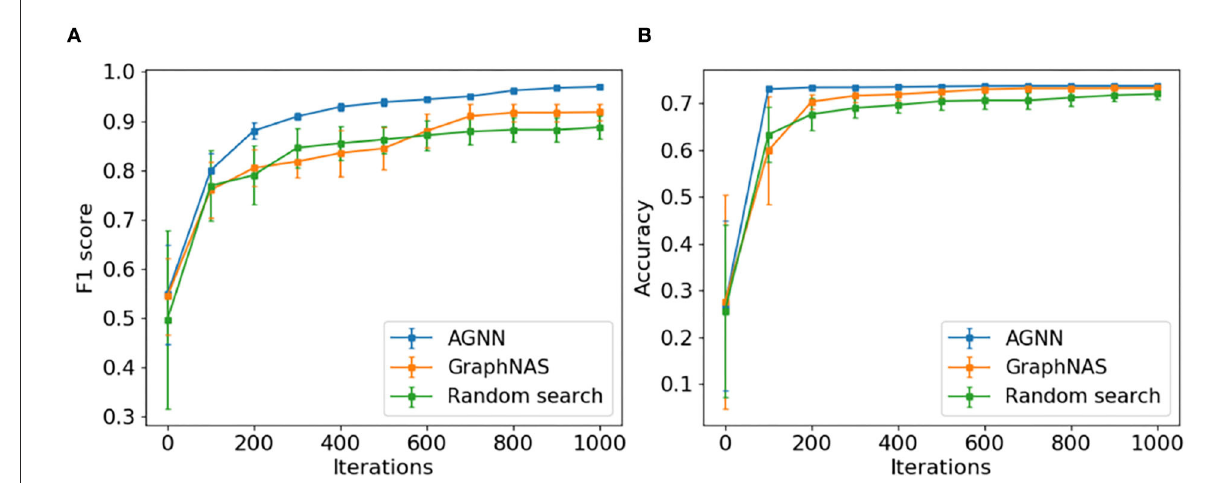
FIGURE3 The progression of top-10 averaged performance of AGNN, GraphNAS, and random search. (A) PPI and (B) Citeseer.